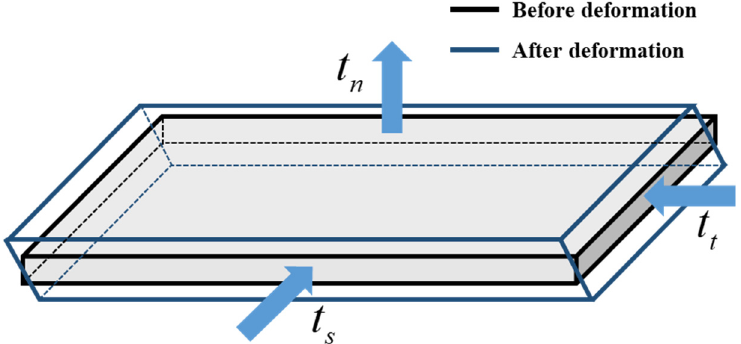
Figure 1. The traction of the three principal directions of the cohesive element and its deformation form.